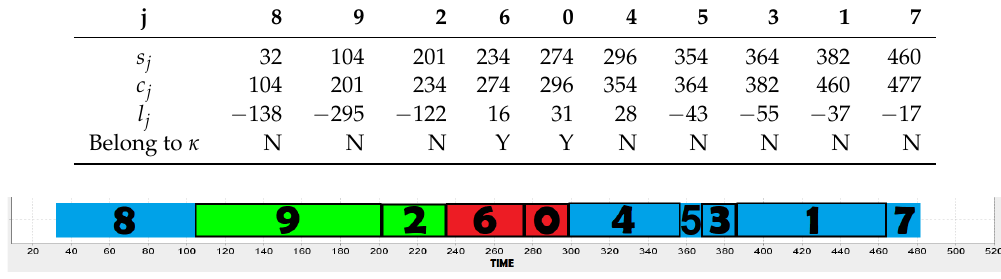
Figure 4. Initial ED-schedule σ . Table 7. A problem instance modified N_3_10 for which kernel K ( σ ) collapses.